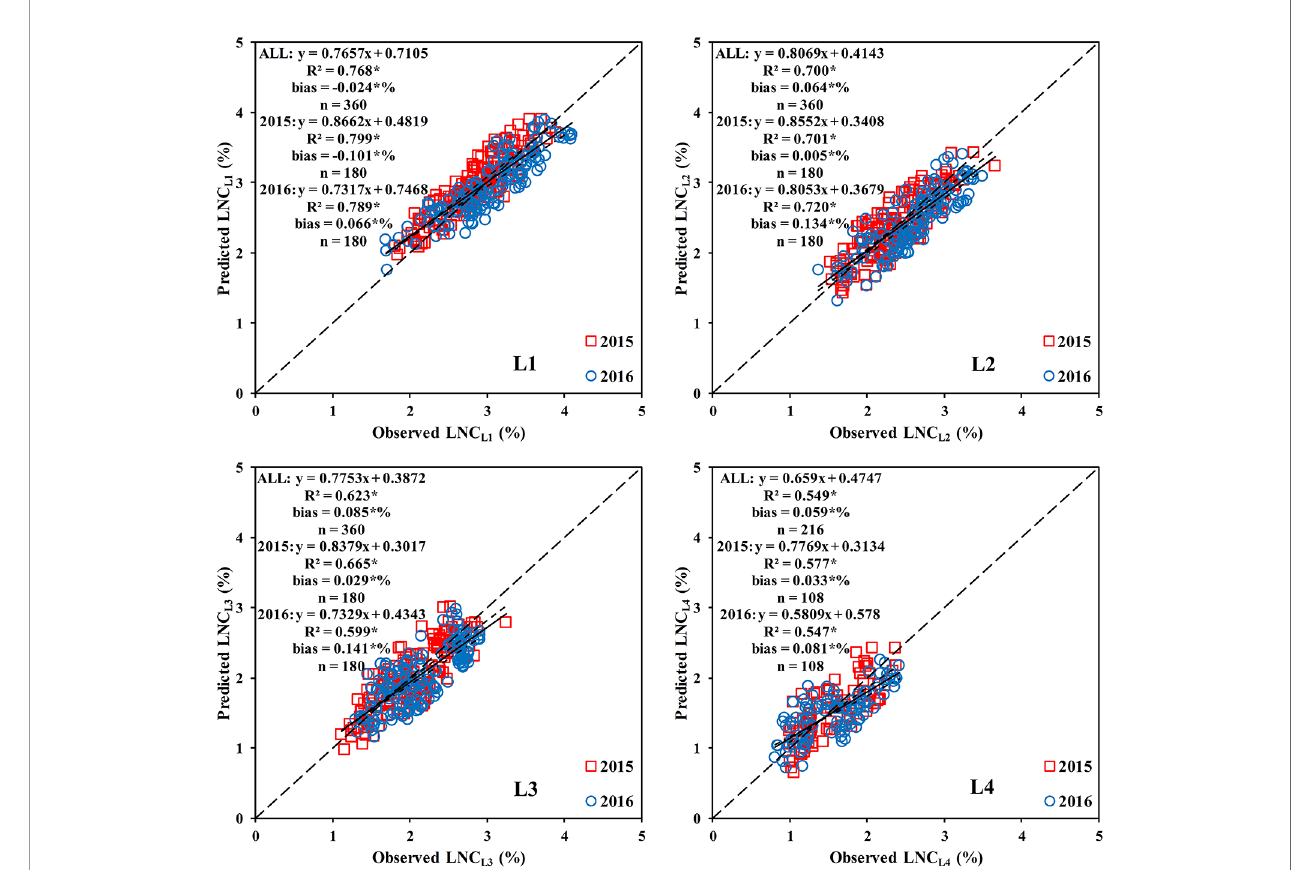
FIGURE 11 | Comparison between the observed and predicted LNC in different leaf layers based on method 2. * means accurate to